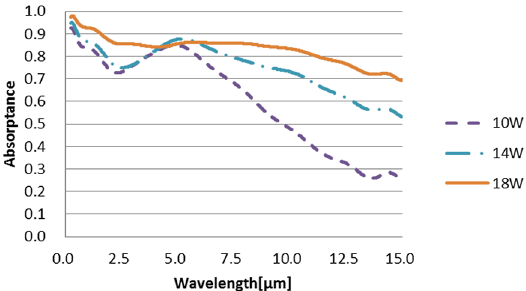
Figure 10. Absorptance spectrum of SS engraved by different power of laser.